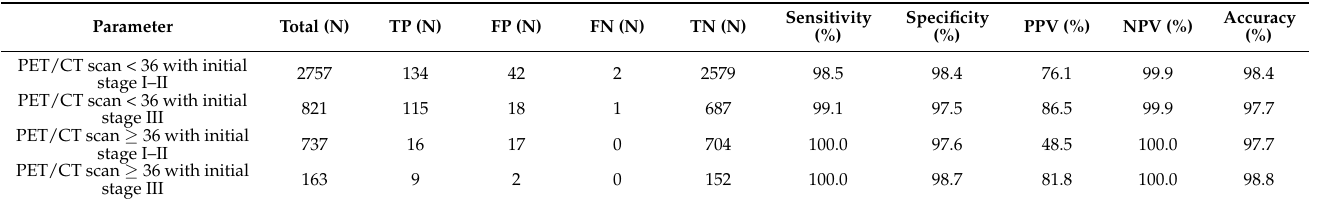
Table 3. Diagnostic performance of surveillance FDG PET/CT scans in subgroups stratified according to initial stage and PET/CT timing after curative-intent therapy.